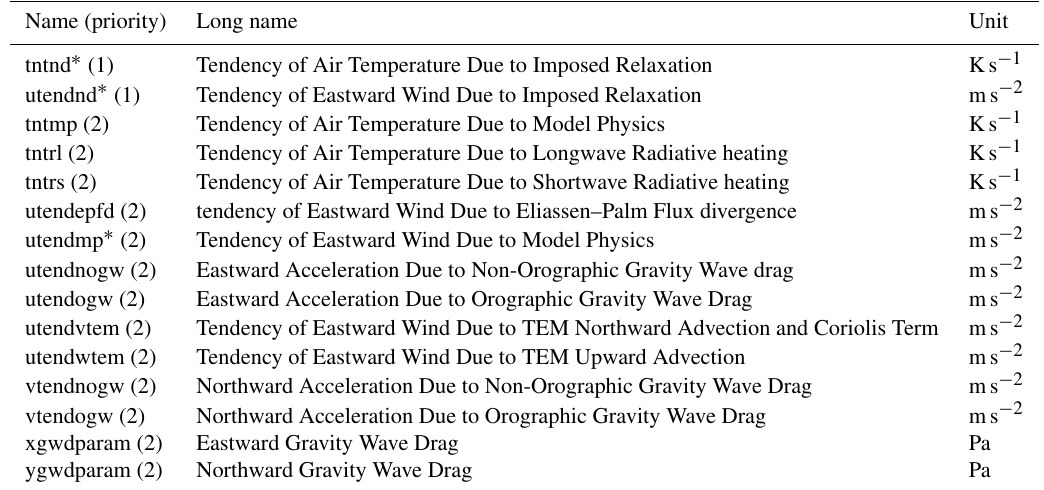
Table 3. Variables in the 6hrZ data table. Zonal-mean output averaged over 6h intervals (YPT). See Sect. 5 for meaning of priority levels. TEM stands for transformed Eulerian